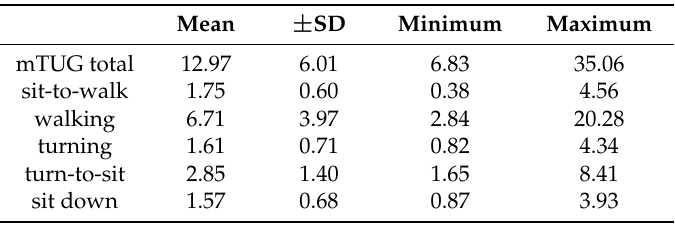
Table 2. mTUG subphases in